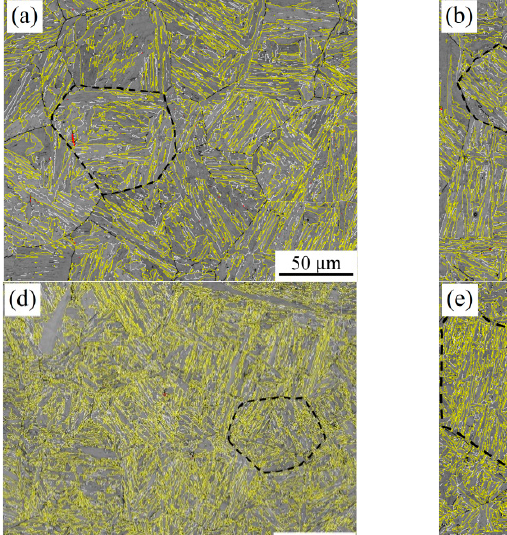
Figure 4. Inverse pole figures (IPF) showing the microstructure of the simulated samples with 0.04 wt.% C ( a – c ) and 0.12 wt.% C ( d – f ) under the different heat inputs: ( a , d ) 10 kJ/cm, ( b , e ) 20 kJ/cm and